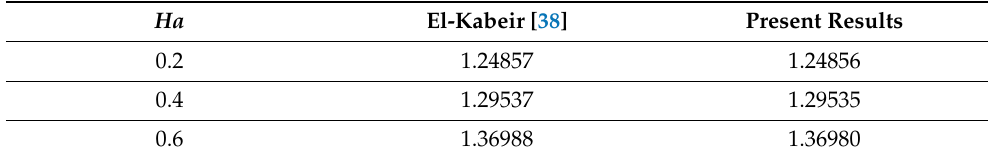
Table 2. Results verification for f (cid:48)(cid:48) ( 0 ) when α = 0. Ha El-Kabeir